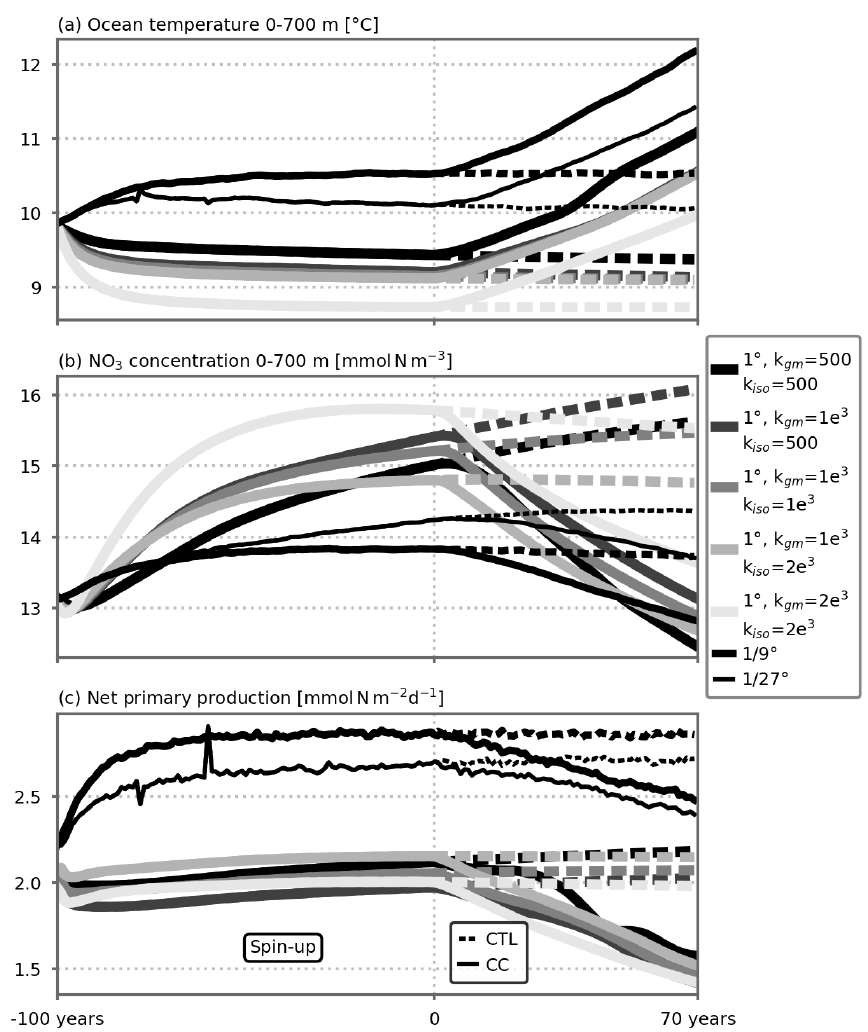
Figure A1. Time series of (a) annual ocean temperature ( ◦ C) and (b) annual nitrate concentration (mmolNm − 3 ) averaged between 0 and 700m depth and (c) vertically integrated net primary production (mmolNm − 2 d − 1 ). All variables are averaged over the whole domain. Years − 100 to 0 correspond to the spin-up period under seasonal preindustrial forcing. The preindustrial control and climate change sim- ulations discussed in this paper start at year 0. Line thickness stands for the different resolutions, and the various shades of gray stand for the various eddy parameterizations. The small peaks in the time series of the 1 / 27 ◦ resolution spin-up around years − 80 and − 60 are due to a problem during the chaining of the spin-up jobs (which were set by periods of 10 years). These errors did not influence the equilibrium states, and we decided not to rerun the spin-up simulations to save computational